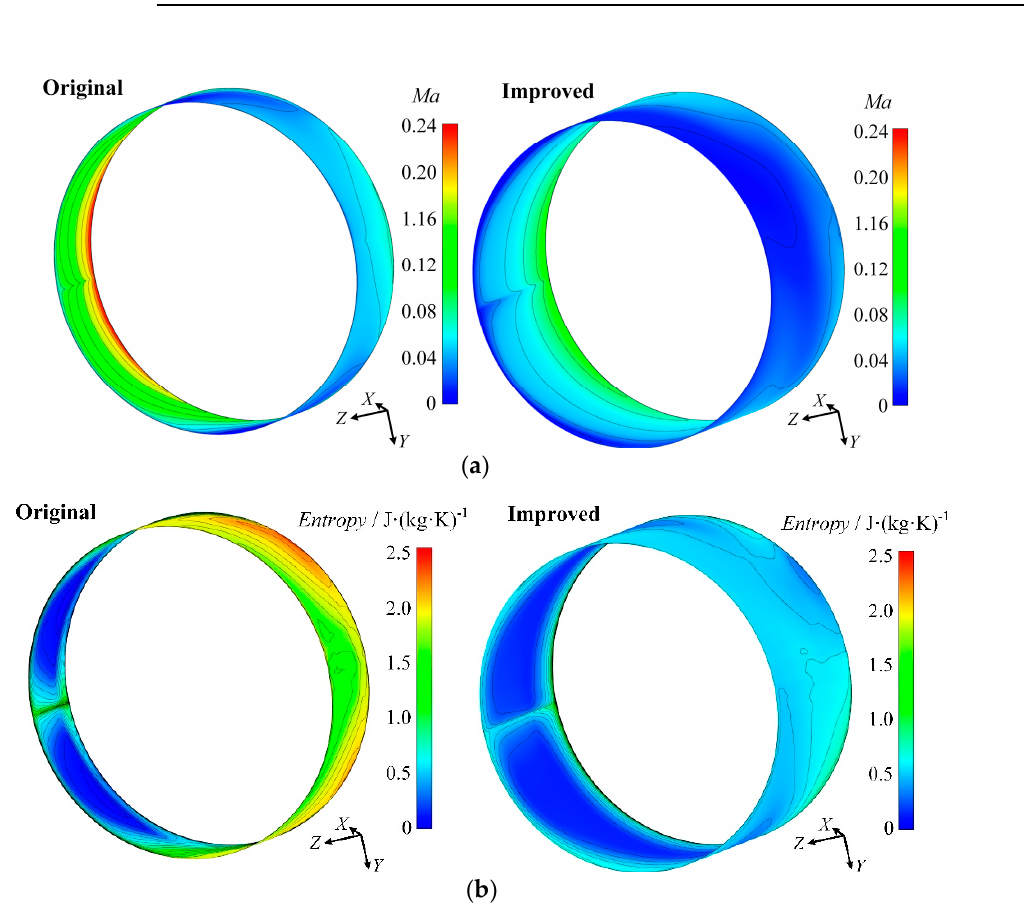
Figure 12. Flow conditions at the exit of the spiral channel. ( a ) Comparison of Mach numbers. ( b ) Comparison of en- tropy. Table 5. Performance comparison of the original and improved radial inlet chambers.